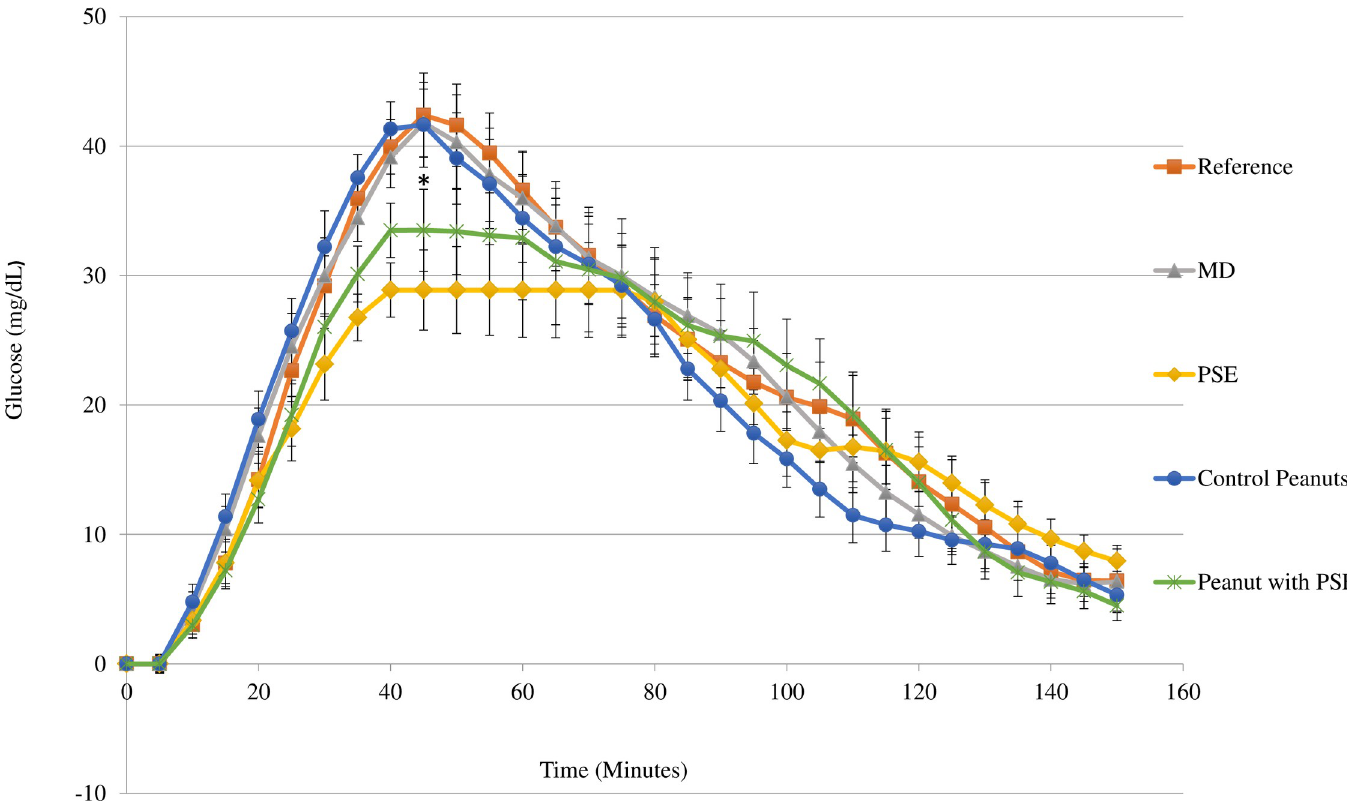
Fig 7. Postprandial change in glucose level from baseline (mean ± SEM) during an oral glucose tolerance test. The fasting glucose level was used a baseline and the change in glucose level is plotted over time for 2.5 hours of the oral glucose tolerance test. Treatments for the oral glucose tolerance test include 50 gram glucose solution either alone ( □ ), with capsule filled with maltodextrin (MD) ( ▲ ),with capsule filled with peanut skin extract (PSE) ( ♦ ), with PSE- fortified peanuts(•), or with non- fortified peanuts( � ) in 15 healthy subjects. Each subject consumed each treatment in triplicate. � Indicates statistically significant difference between treatments (P < 0.05).